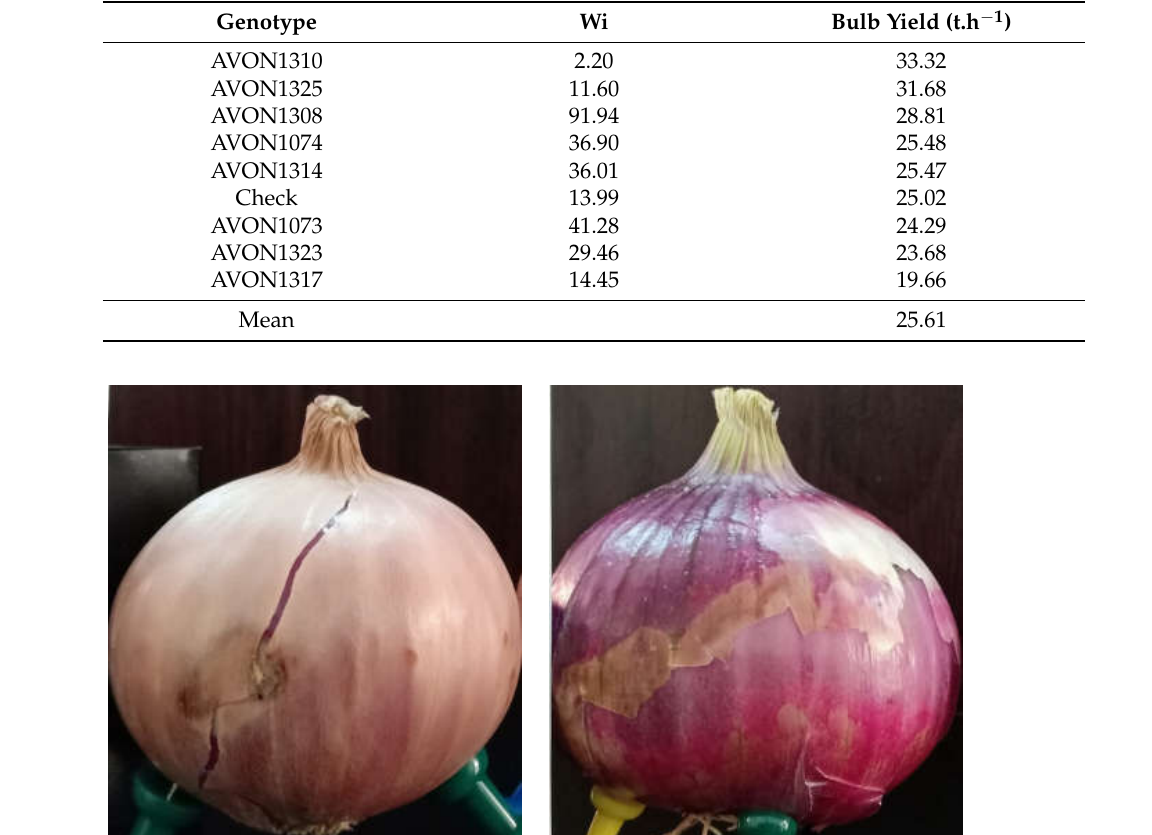
Table 5. Lin and Binns’ superiority measure of genotype performance Table 4. Wricke’s ecovalence stability of coefficients Wi.